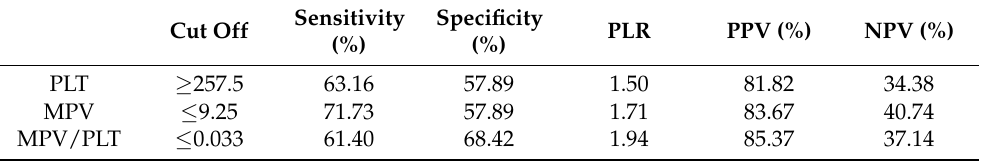
Table 3. Diagnostic parameters for plt, mpv and mpv/plt between HGUC and